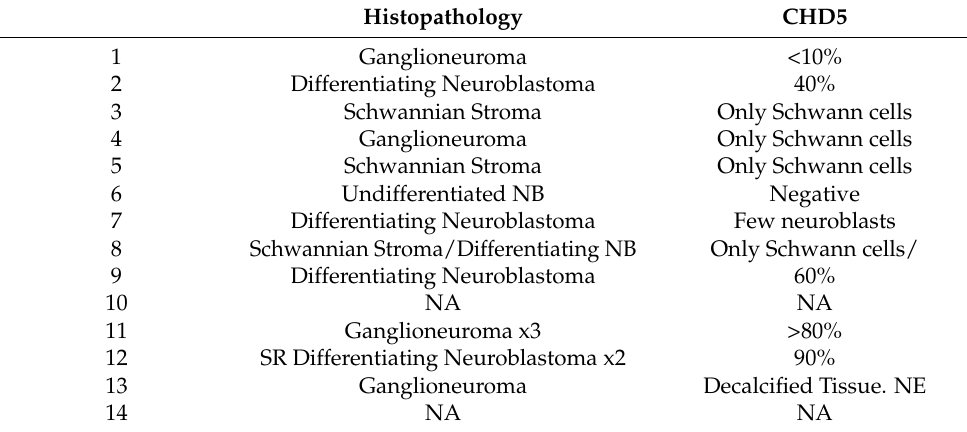
Table 2. Histopathological findings of all cases in the study.